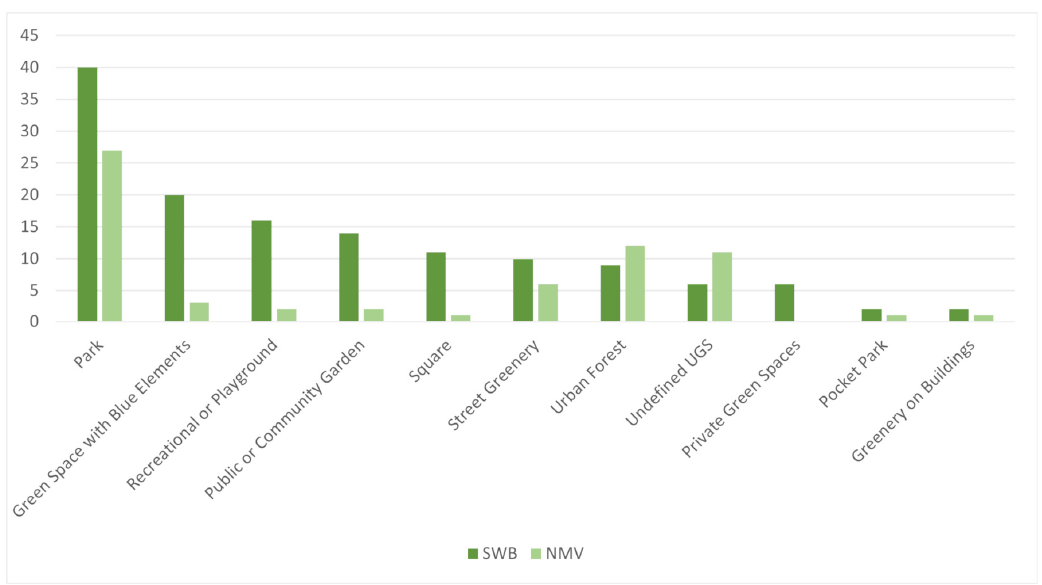
Figure 8. Types of urban green spaces studied per category of articles.